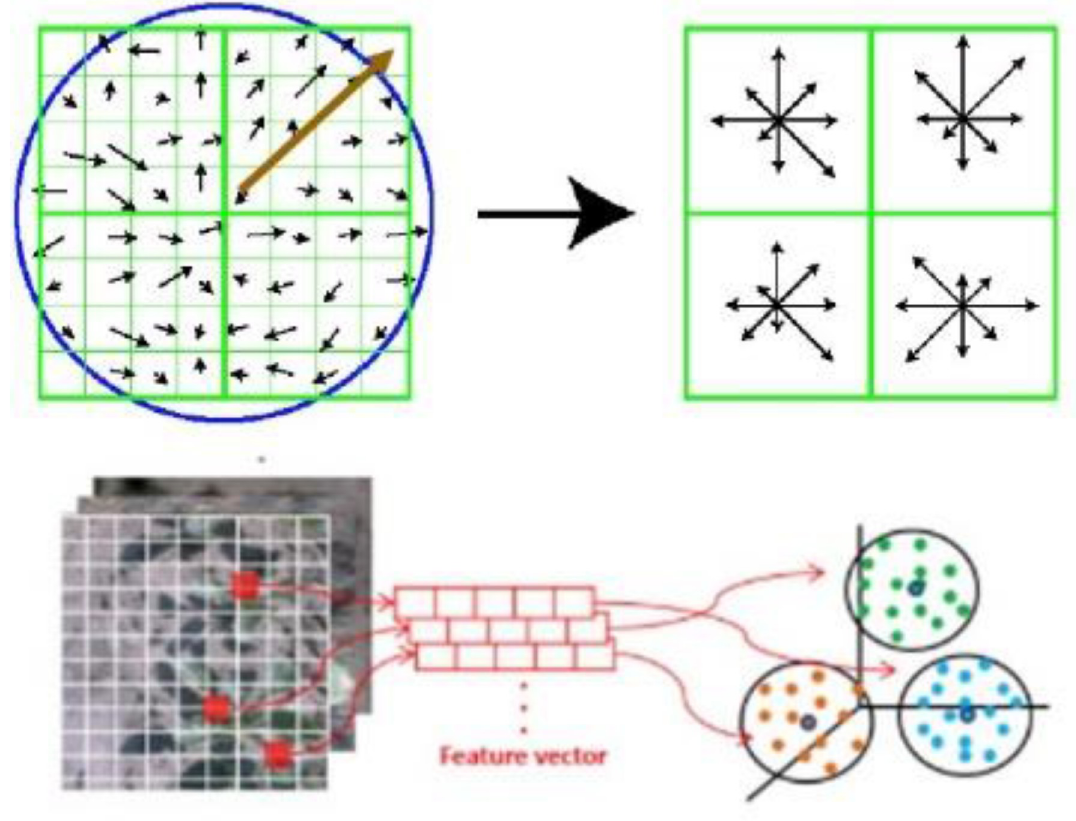
Fig 4. SURF feature extraction and